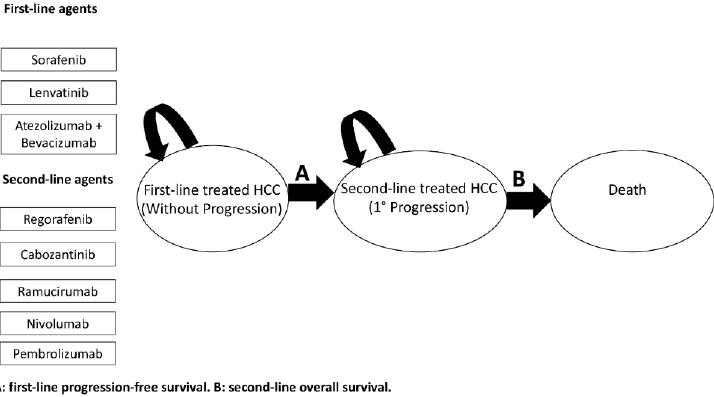
Figure 1. General structure of the Markov model used.